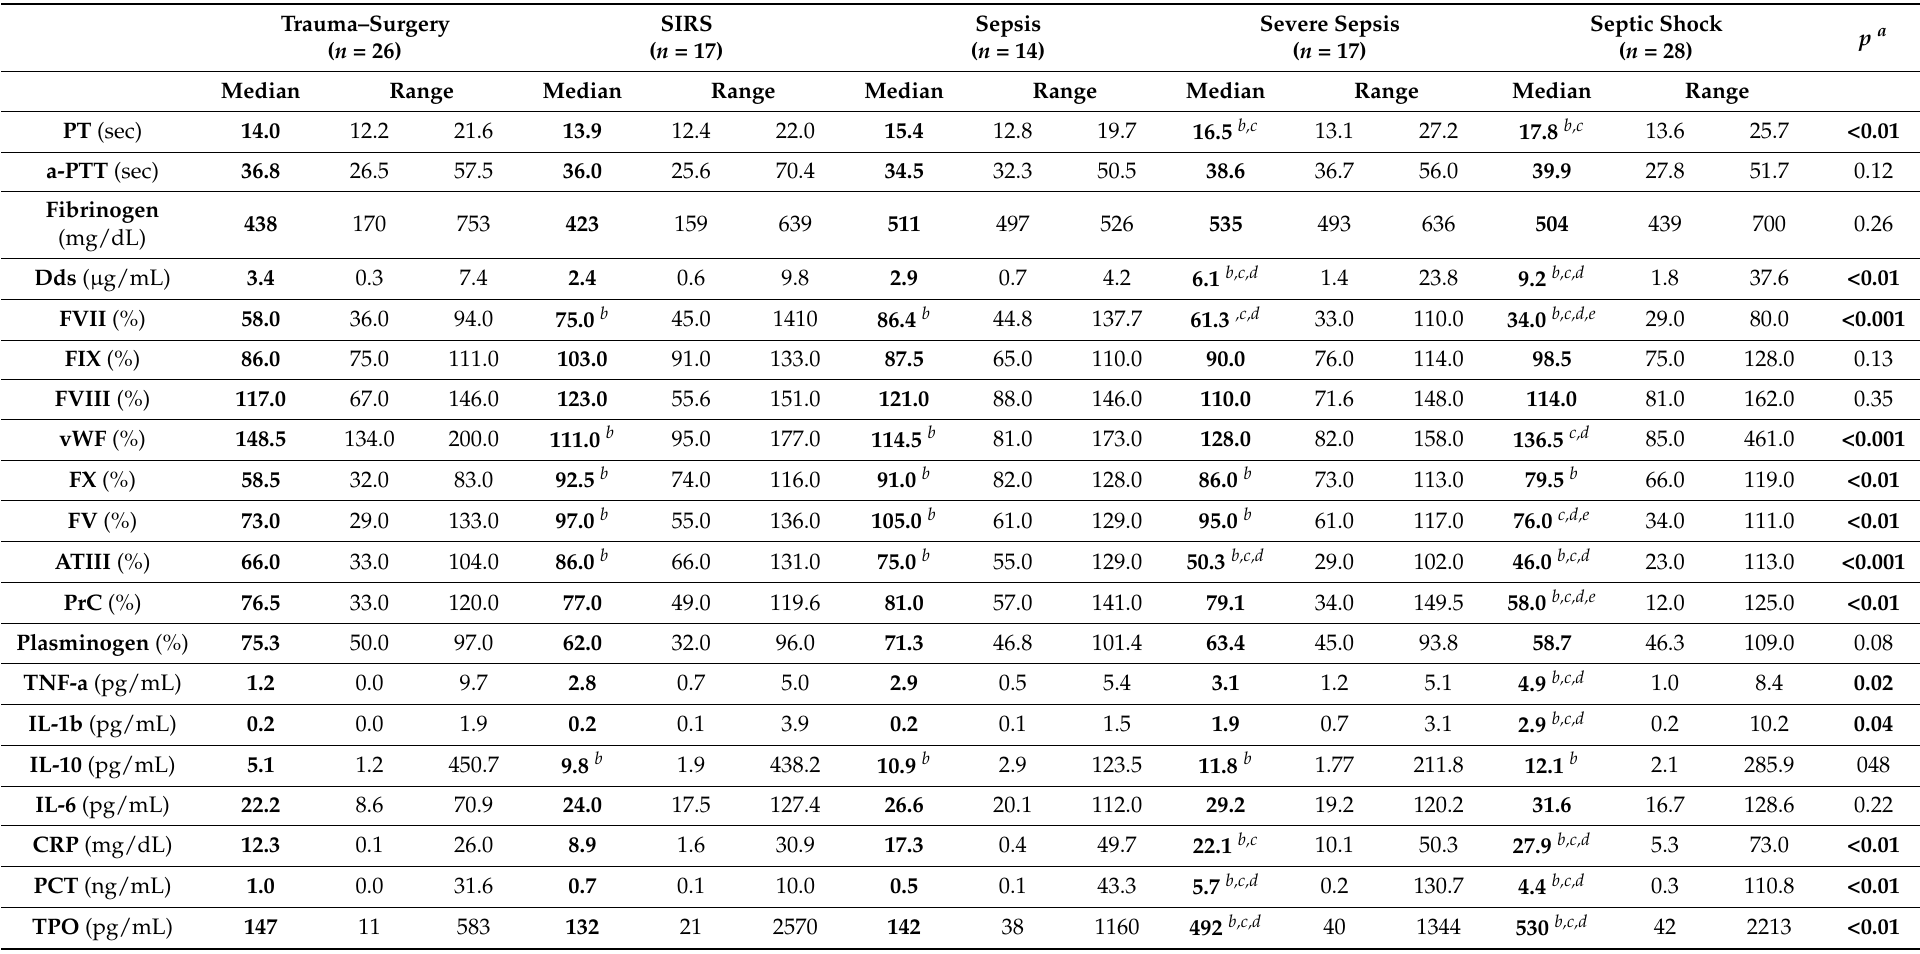
Table 2. Measurements of the coagulation system, cytokines, and inflammatory markers of patients on ICU